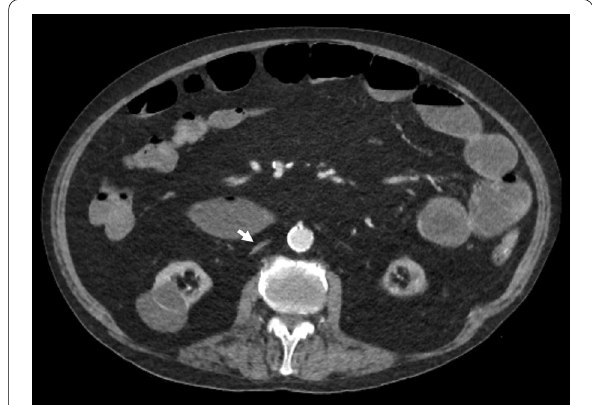
Fig. 24 Slit-like IVC from hypovolaemia. Axial-enhanced CT image demonstrates a slit-like IVC or ‘flat cava’ sign (arrow), consistent with the patient’s clinically evident hypovolaemia following surgery